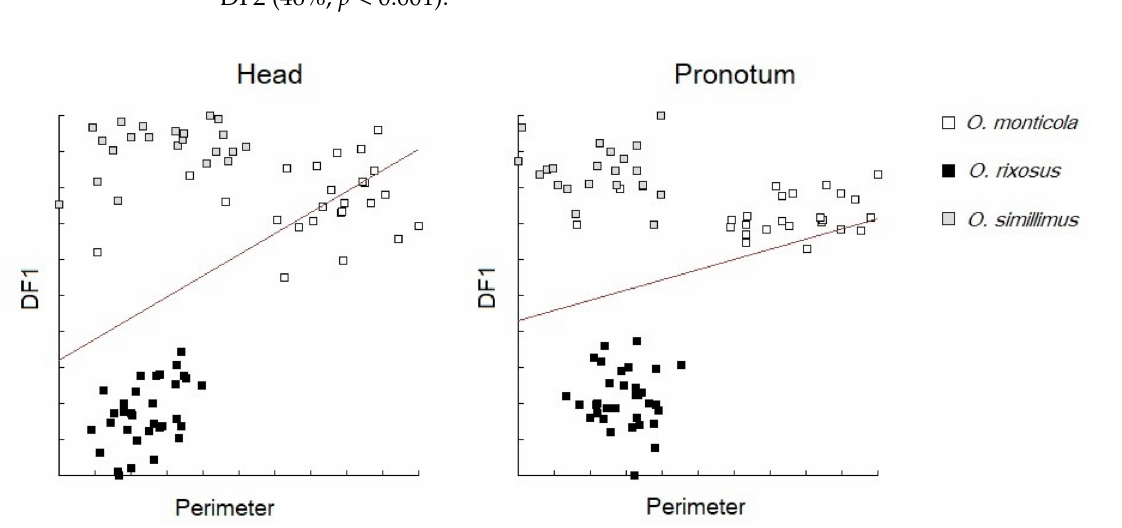
Figure 3. Linear regression lines between the first shape-based discriminant factor between three Odontomachus species and the corresponding size of head ( left ) and pronotum ( right ) contours.